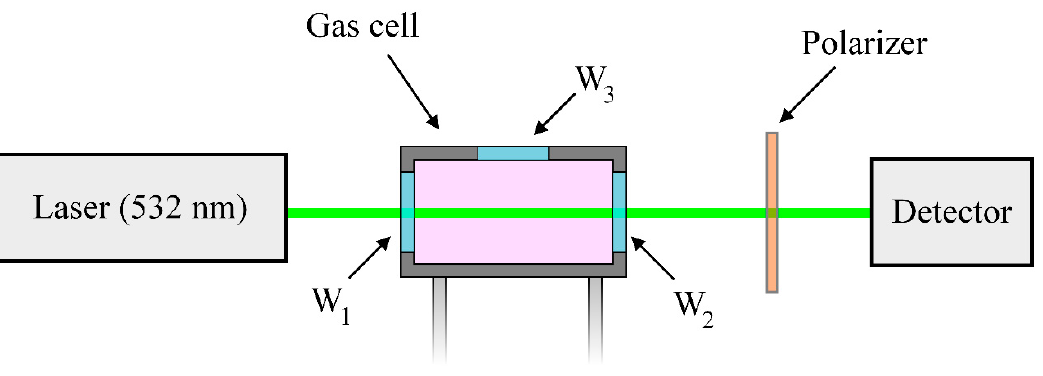
Figure 6. Schematic of the experimental setup used to evaluate the effect of polarization scrambling. Here, W 1 , W 2 , and W 3 denote the windows of the gas cell.